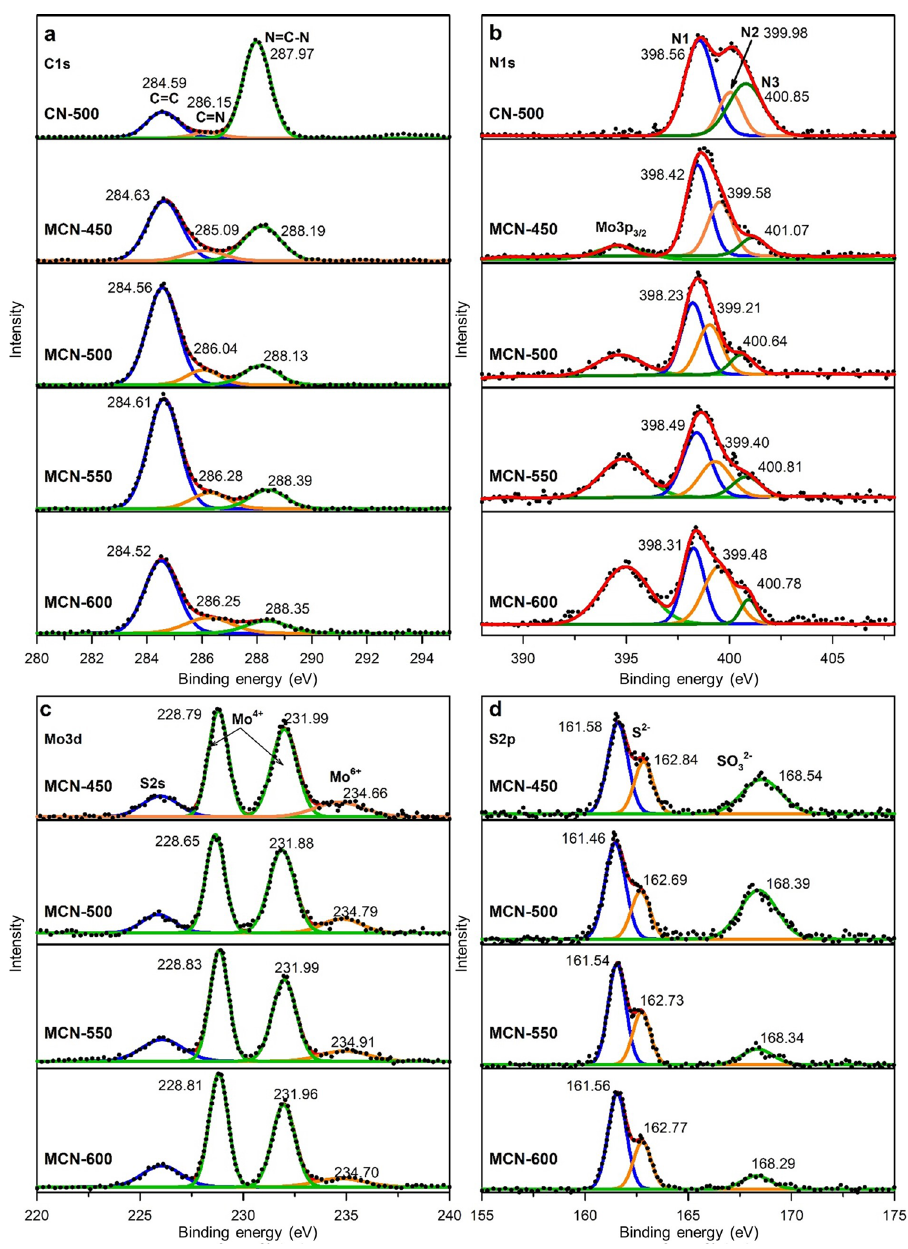
Figure 3. ( a ) C1s; ( b ) N1s XPS spectra of CN-500 and MCN-T; ( c ) Mo3d; and ( d ) S2p XPS spectra of composites MCN-T (T = 450, 500, 550, and